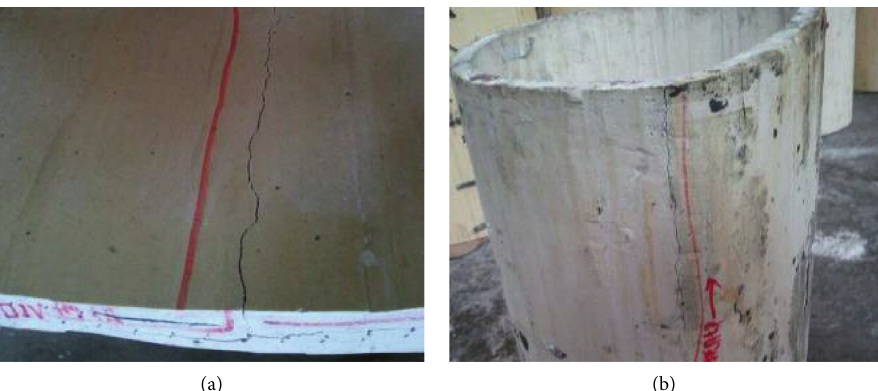
Figure 10: Lining cracks of the reinforced concrete. (a) The first crack (inverted arch), (b) The third crack (left side wall feet).